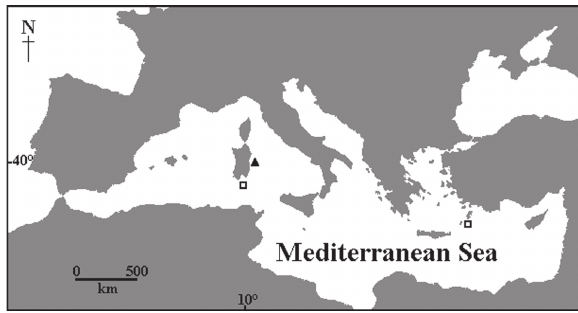
Fig . 1. – Distributional map of Gaidropsarus granti documented records in the Mediterranean Sea. Black triangle indicates the site of collection of the present specimen. Empty squares indicate localities of previously recorded